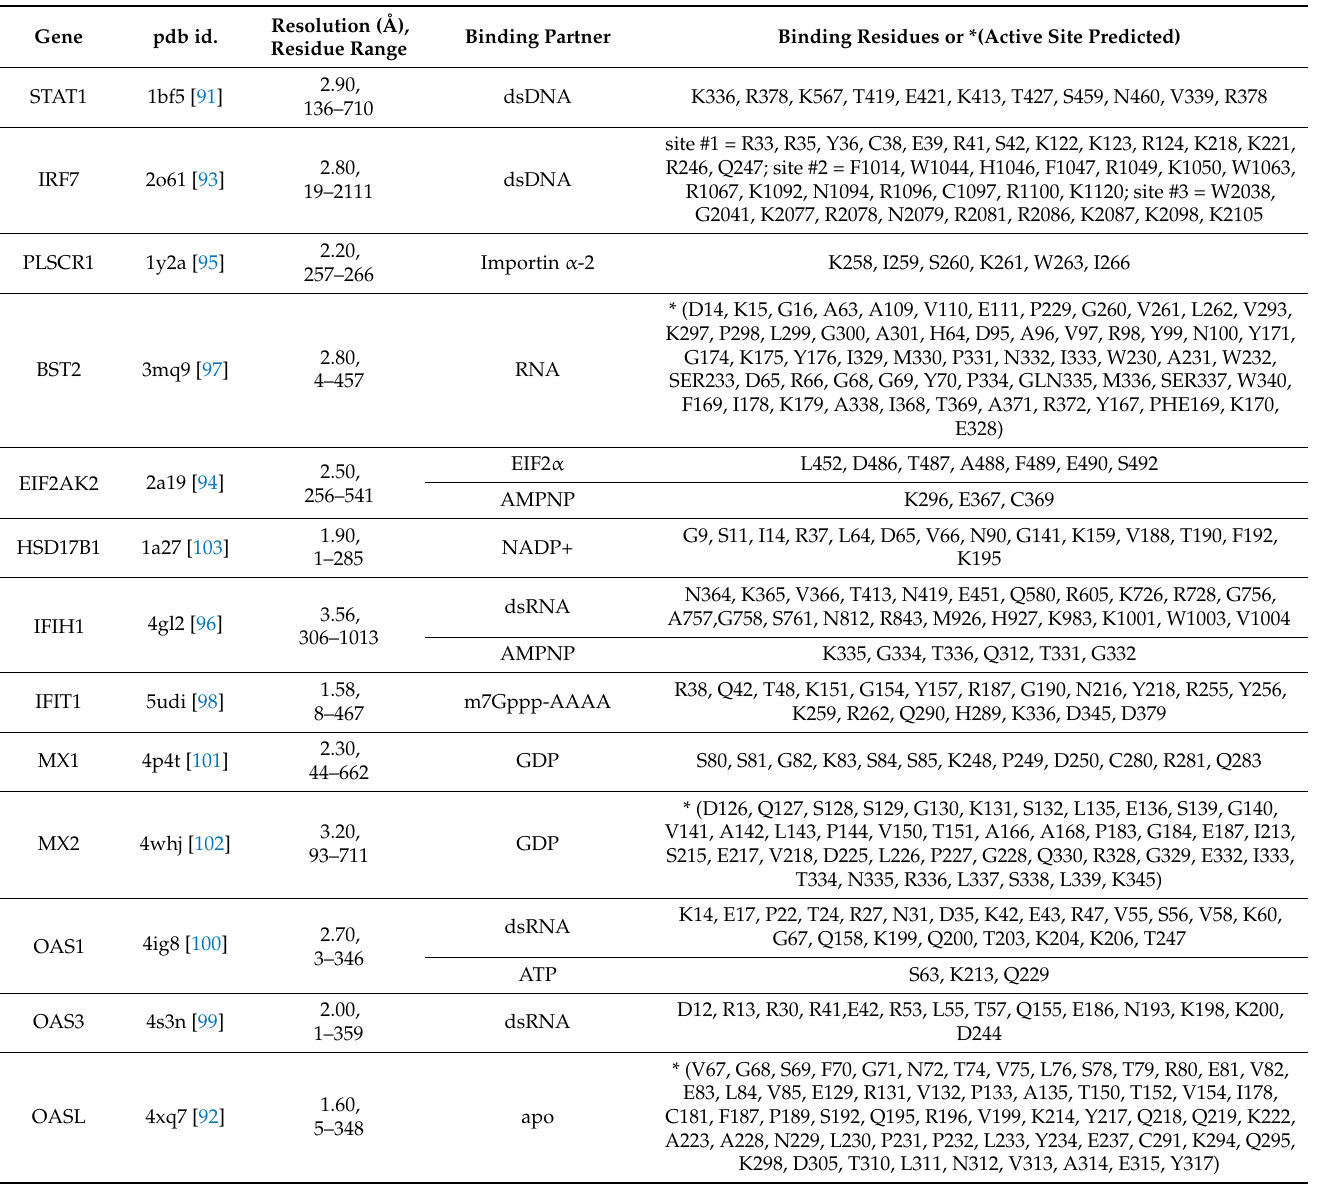
Table 2. Residues defining the pharmacohpore model for STAT1, PLSCR1, BST2, EIF2AK2, HSD17B1, IFIH1, IFIT1, IRF7, MX1, MX2, OAS1, OAS3 and OASL genes, generated from the crystal structures or predicted using the homology modelling approach using the MOE (Chemical Computing Group Inc., Montreal, QC, Canada)